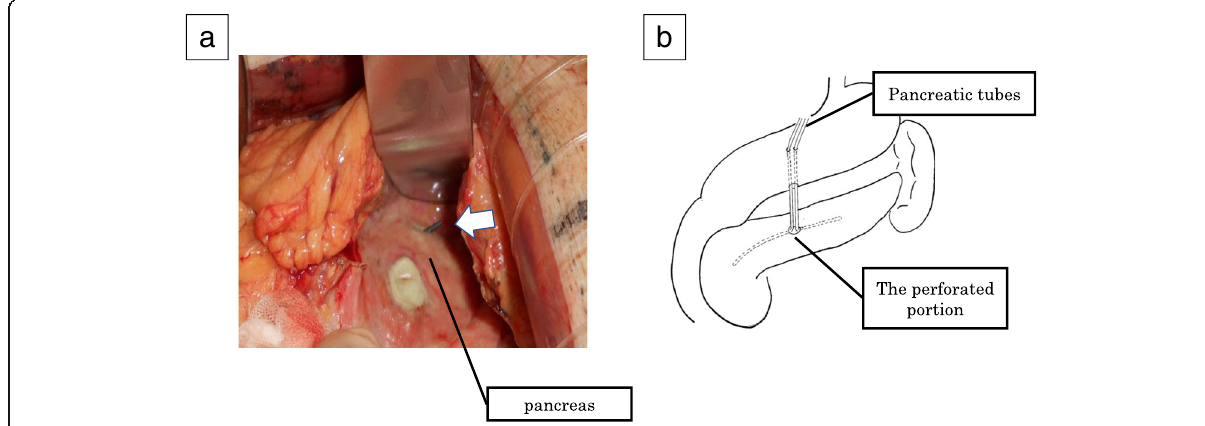
Fig. 2 Operative findings. a A pancreatic stent protruded from the pancreatic body (arrow). b Pancreatic tubes were inserted into both sides of the perforated site, and external drainage was performed through the stomach. We performed percutaneous transgastric